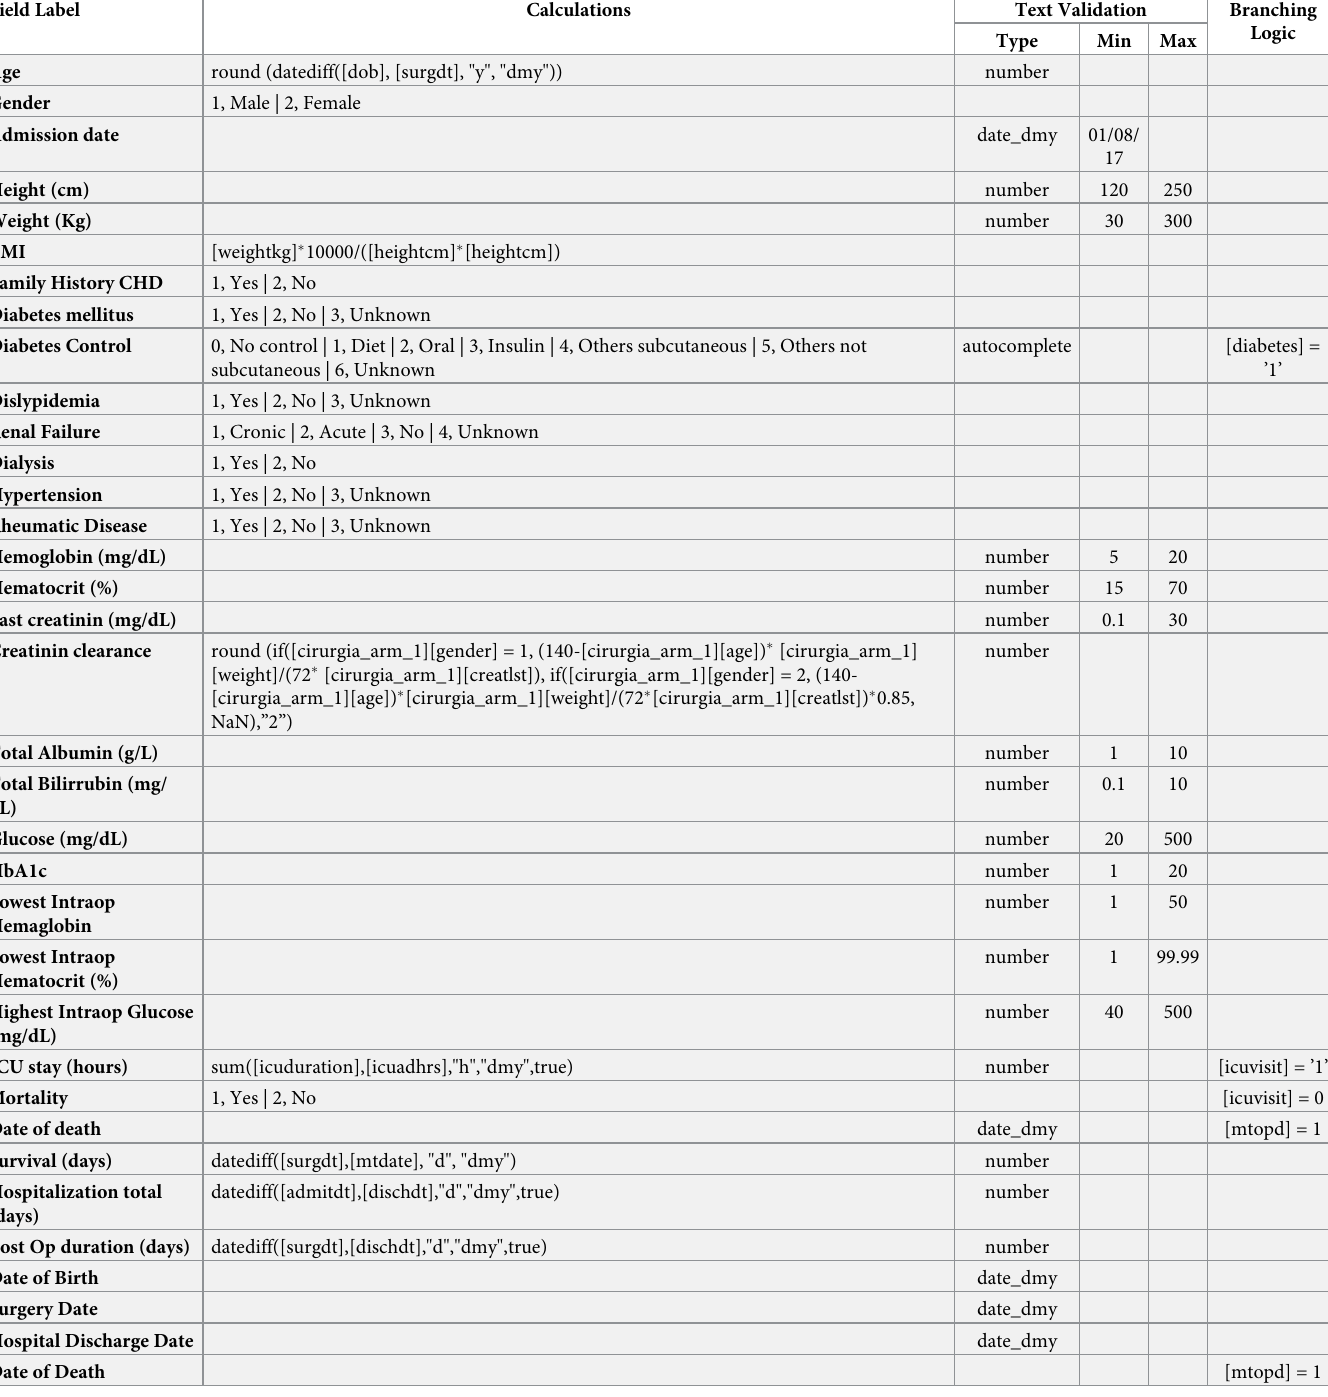
Table 5. Rules applied to the RedCAP tools after the indirect audit considering better criteria and definitions to improve data quality in REPLICCAR II Study. REPLICCAR II, 2019. Field